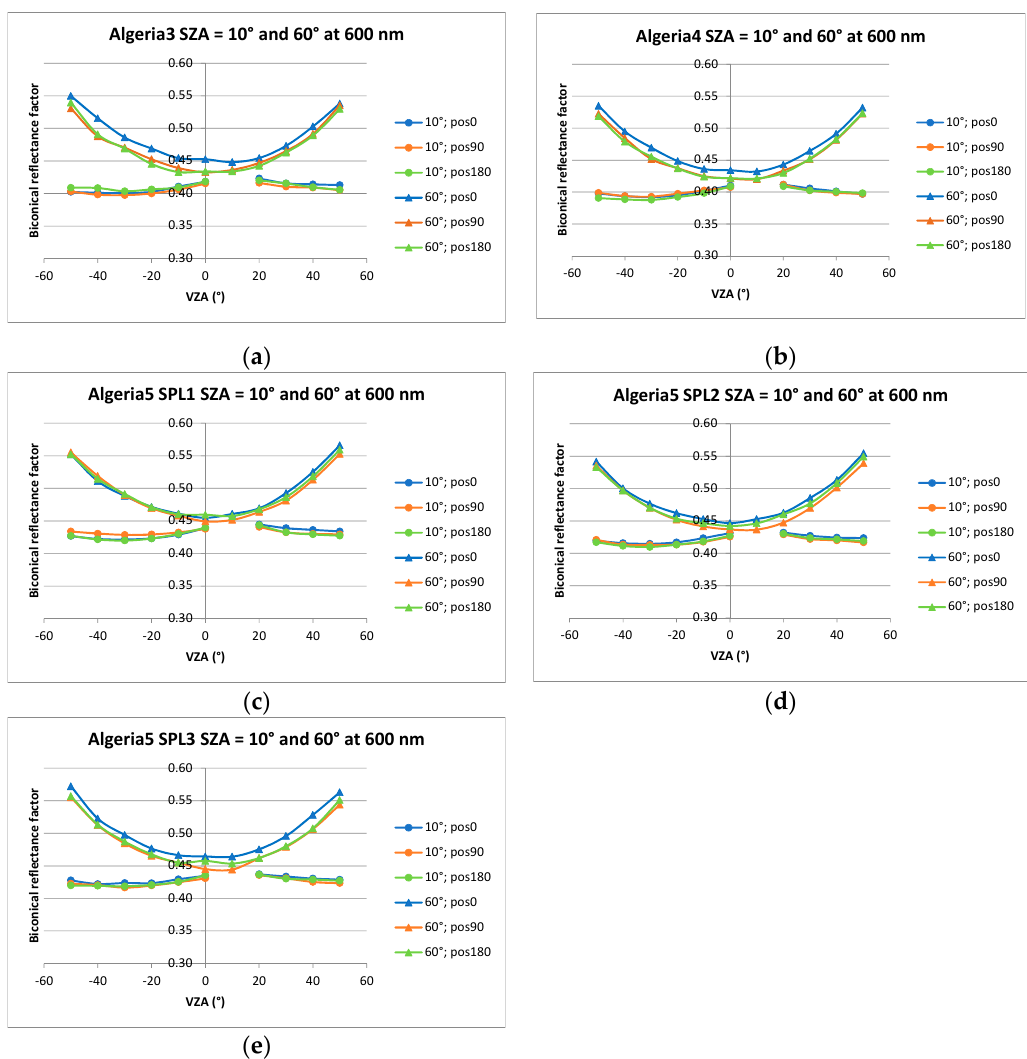
Figure 11. BCRF for the minimum (10°) and the maximum (60°) solar zenith angles, in the principal plane, for Algerian samples: ( a ) Algeria3;( b ) Algeria4; ( c ) Algeria5 sample 1; ( d ) Algeria5 sample 2; ( e ) Algeria5 sample 3.